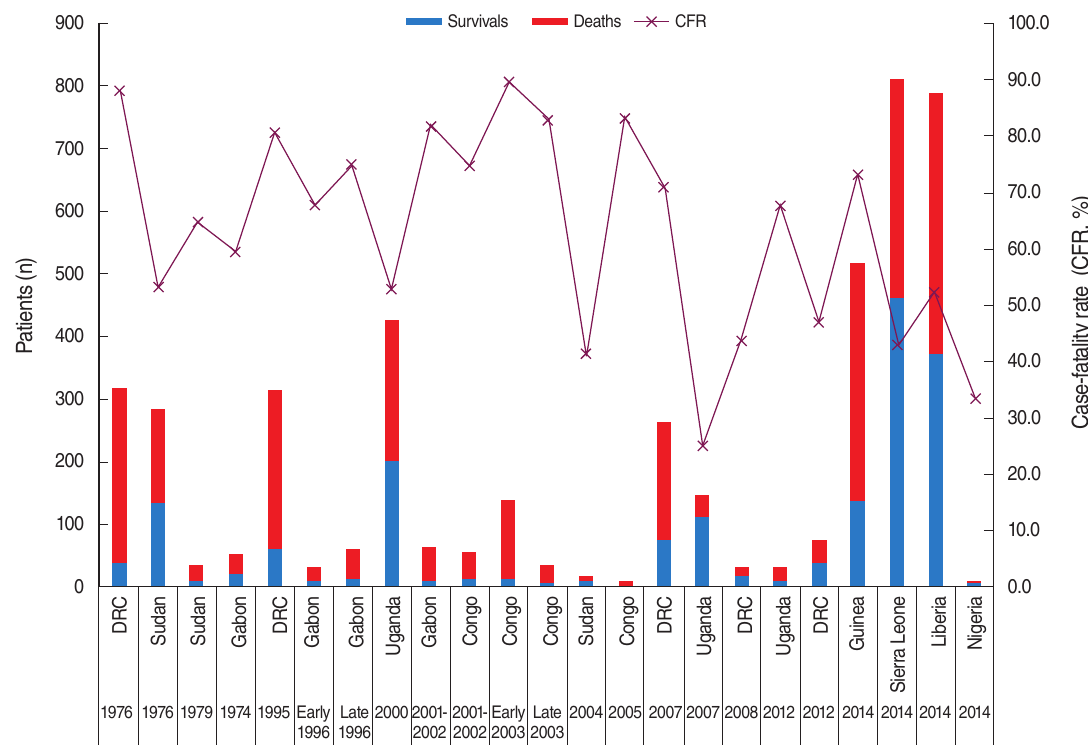
Figure 1. Survival and fatality rates associated with Ebola outbreaks (as of Aug 13. 2014). DRC, Democratic Republic of Congo. From World Health Organization. Ebola virus disease update-west Africa